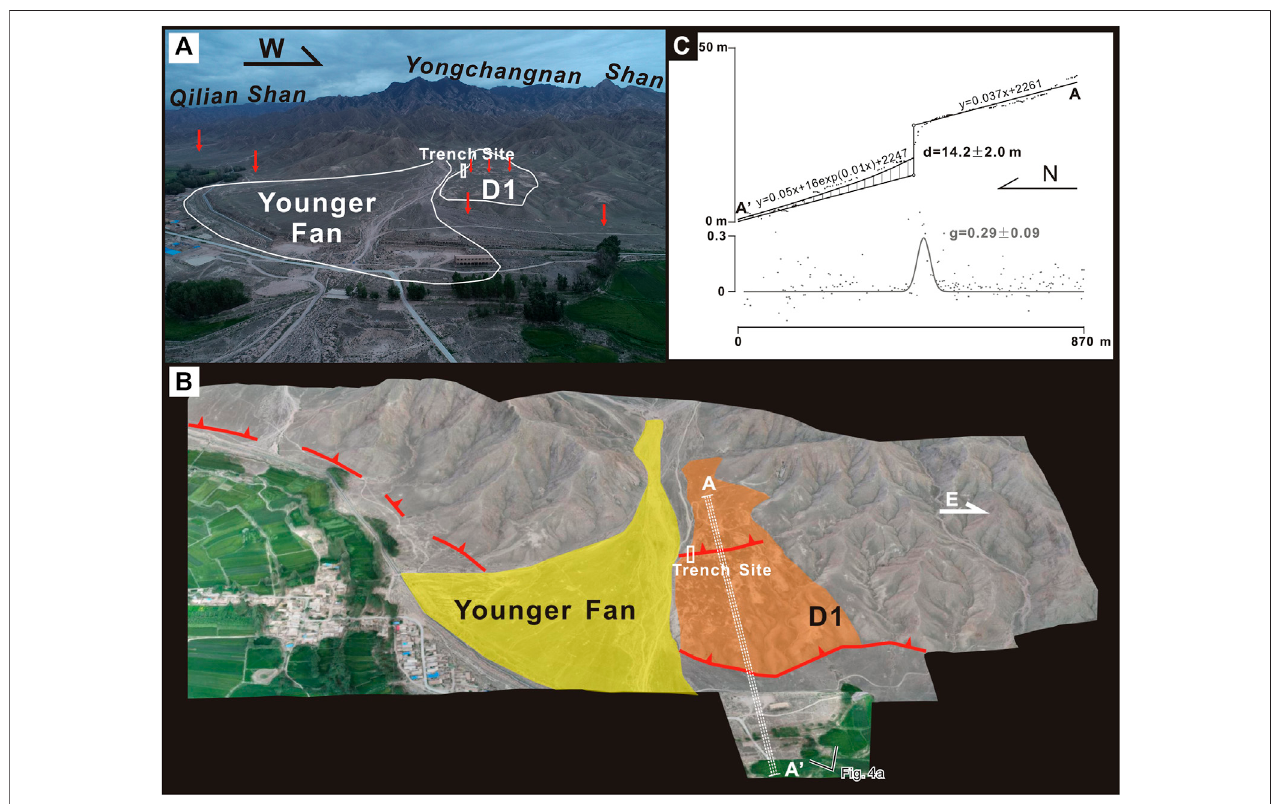
FIGURE 4 | (A) Aerial photography of the Dujiatuan village site. The red line shows the fault track. (B) 3D topography of the surveyed site. The measuring lines are normal to the fault strike. (C) The topographic pro fi le reveals the vertical throw and the Gaussian fi tting indicates the maximum slope on the scarp.